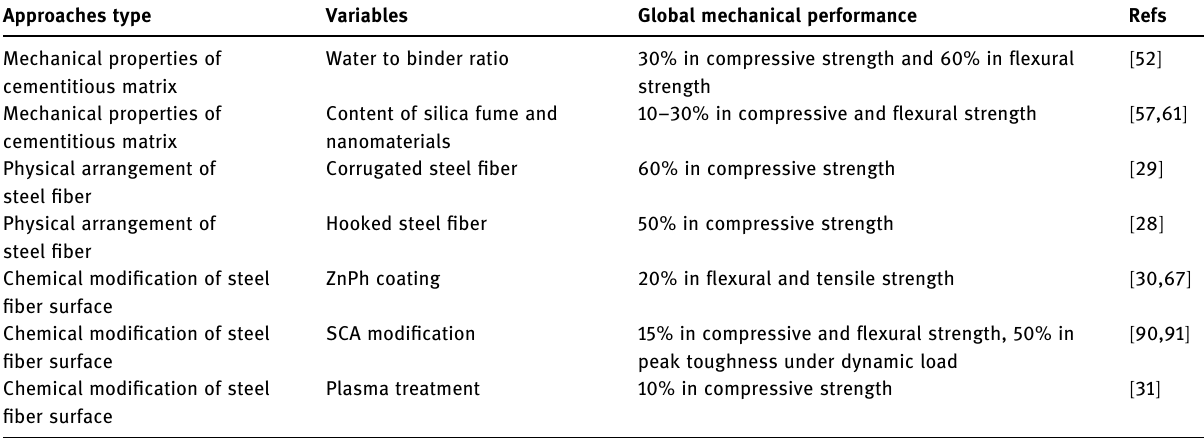
Table 2: E ff ect of enhancement approaches on the global mechanical performance of SFRCC Approaches